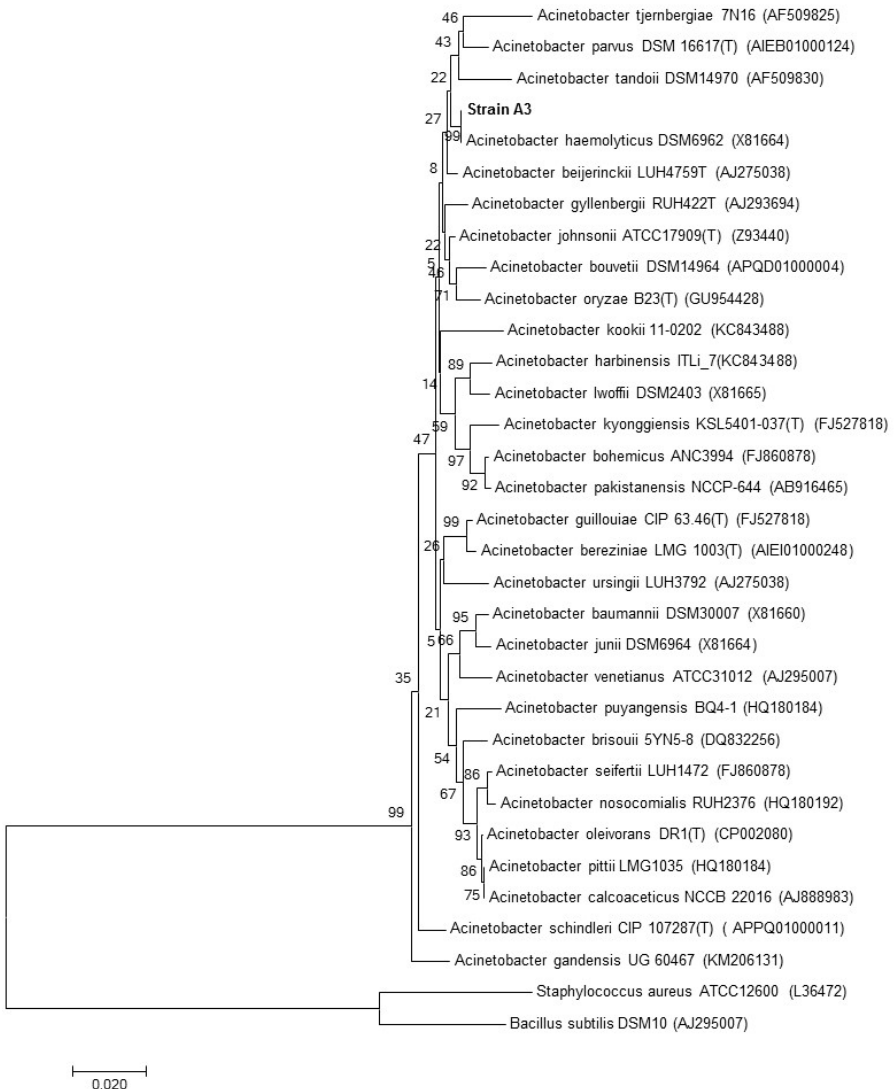
Figure 3. Neighbor-joining phylogenetic tree based on 16S rRNA gene sequences, showing the nearest neighbors of strain A3. Bacillus subtilis and Staphylococcus aureus type strains were used as an outgroup. Bootstrap values (expressed as percentages generated from 1000 replicates) greater than 50% are shown at branch points. GenBank accession numbers are given in parentheses. The bar represents 0.02 substitutions per site.